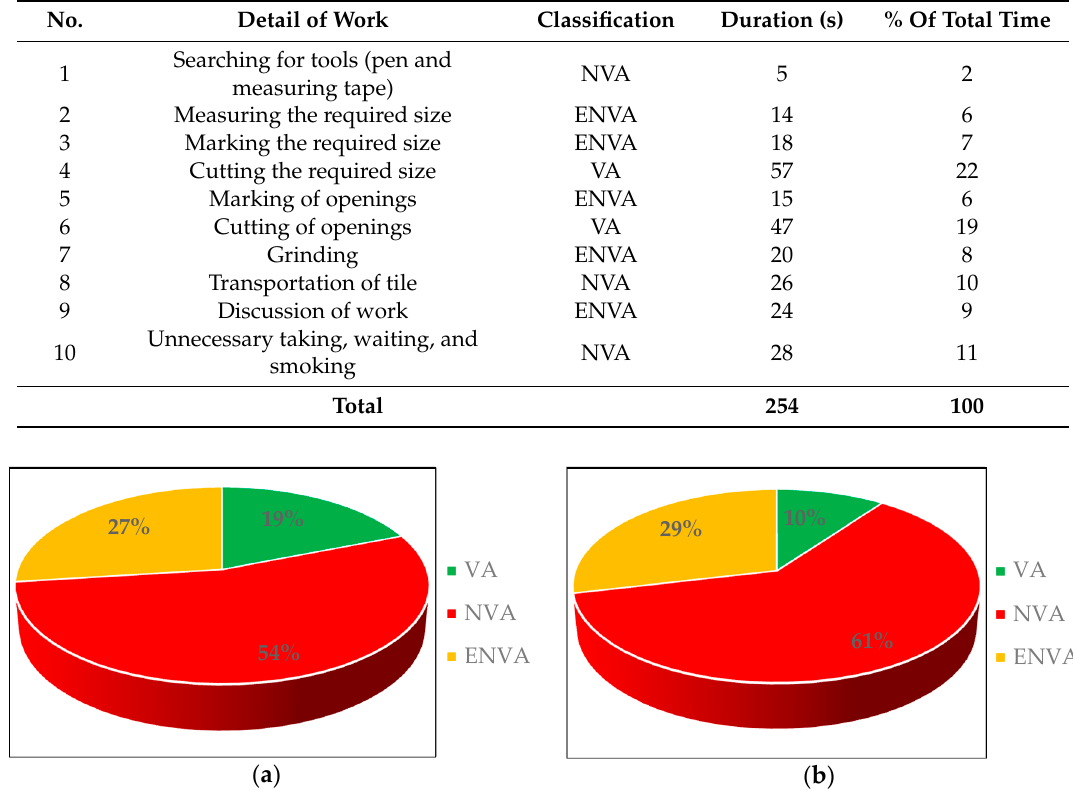
Figure 1. Summary of the VSM data of the process “installation of floor slab” ( a ) for person 1—crane operator, ( b ) for persons 2 and 3—installation workers.